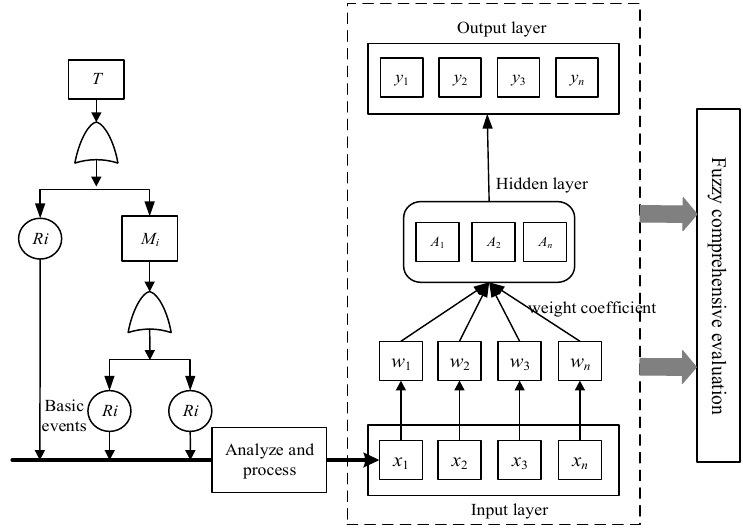
Figure 4. Schematic diagram of fault tree embedded BP neural network.